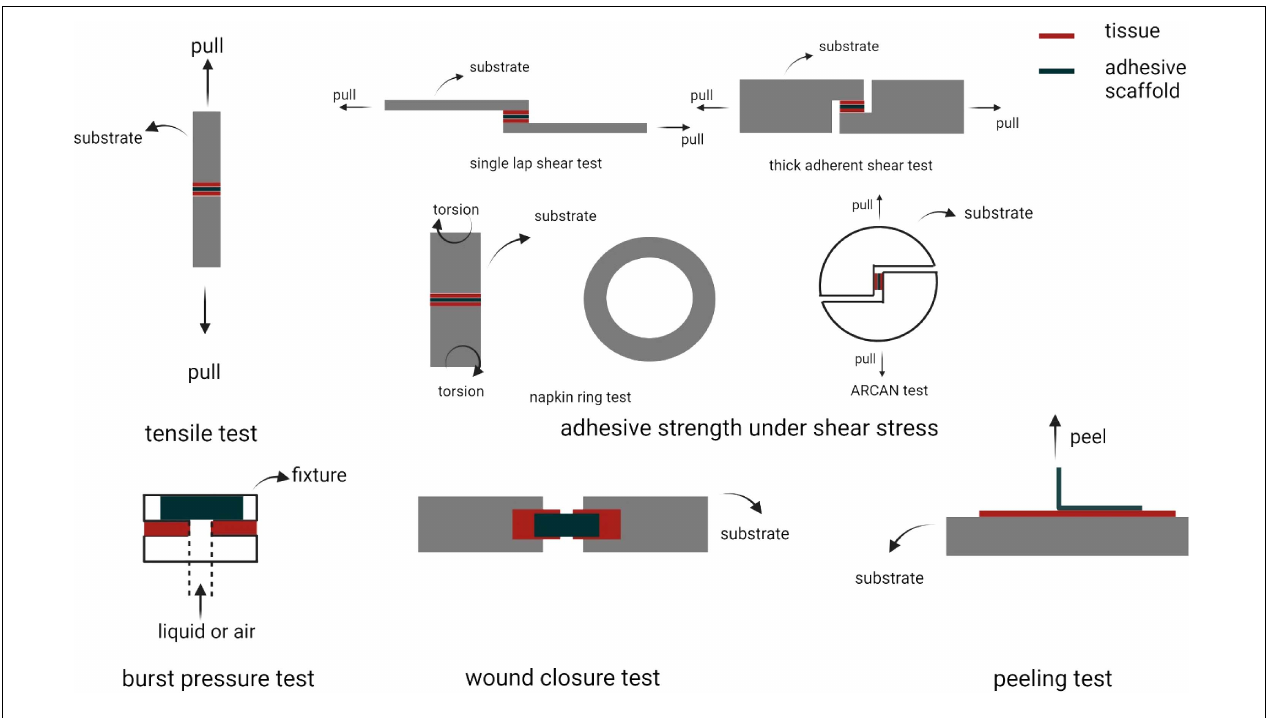
FIGURE 2 | Different methods to assess adhesion strength. Created with